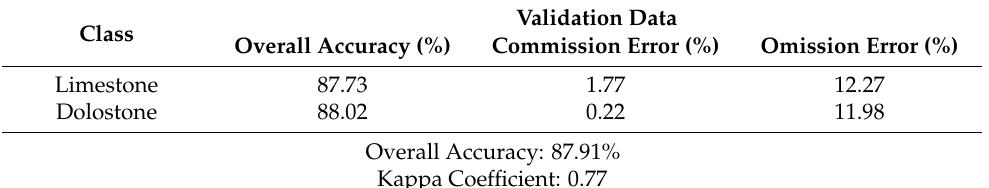
Table 5. Confusion matrix table of the validation data for the classification results from the BLR